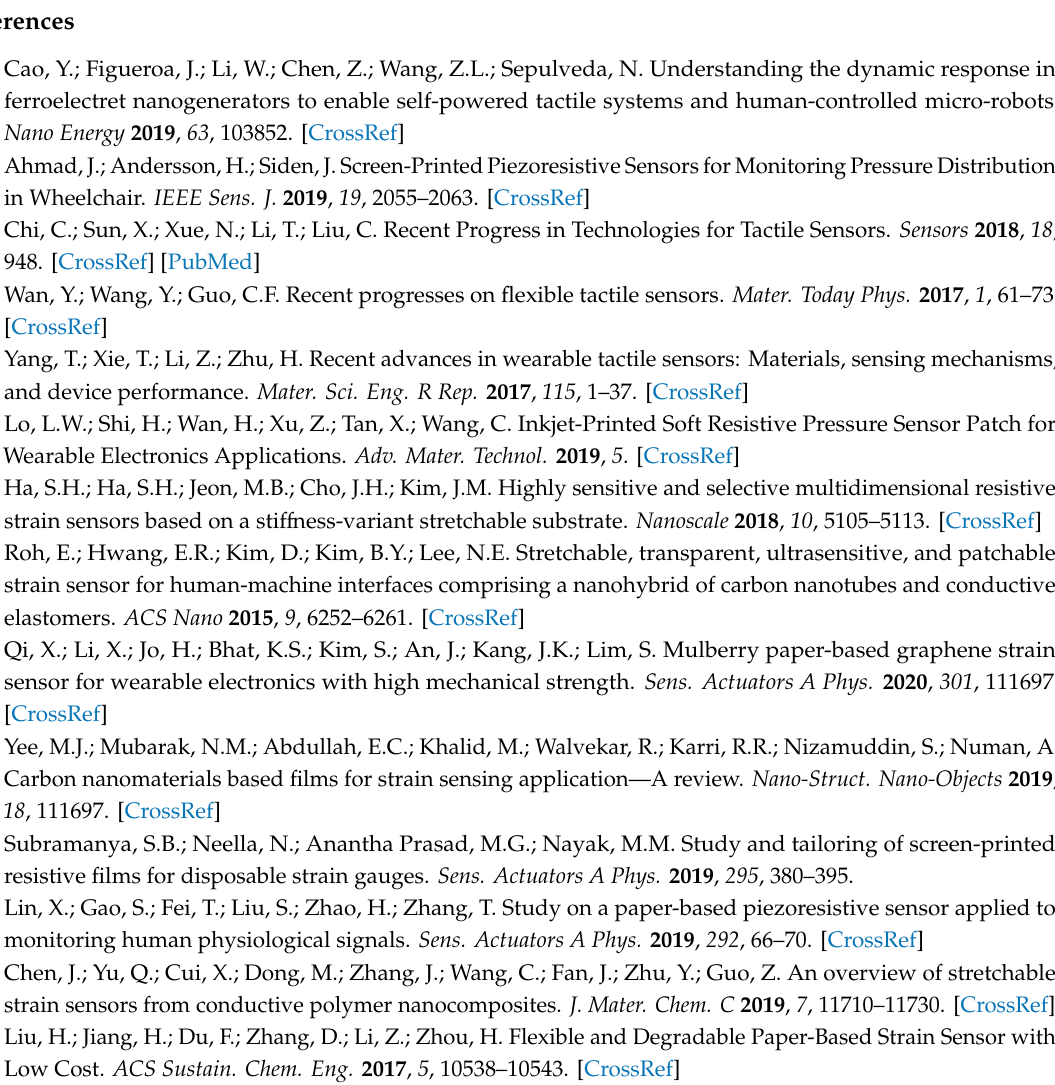
Table S1: The impedance variation of the composite depending on CB / PVA ratio and frequency, Table S2: Color map showing the change in the current as the specified location is pressed. (Locations are labeled in Figure 4c.), Figure S1: (a)–(b) Optical images of CB / PVA composite with ratio of 0.2, Figure S2: Optical images of CB / PVA composite with ratio of 0.2. Exposing visible light from the blank side of the cellulose paper reveals that there are no macro-scale defects observable on the ink material, Figure S3: Optical images of CB / PVA composite with ratio of 1.2. Clustering of CB particles is observable even with bare eye, Figure S4: CB / PVA composite with ratio of 1.2. Exposing visible light from the blank side of the cellulose paper reveals the non-uniformity, as well as pores in the ink material. Figure S5: The equivalent circuit of the sensor structure (extended version of the equivalent circuit given in Figure 2d). The simulation is realized for a 5V, 200 Hz signal. The pressure is applied to Location #16 (labeled in Figure 4c in the